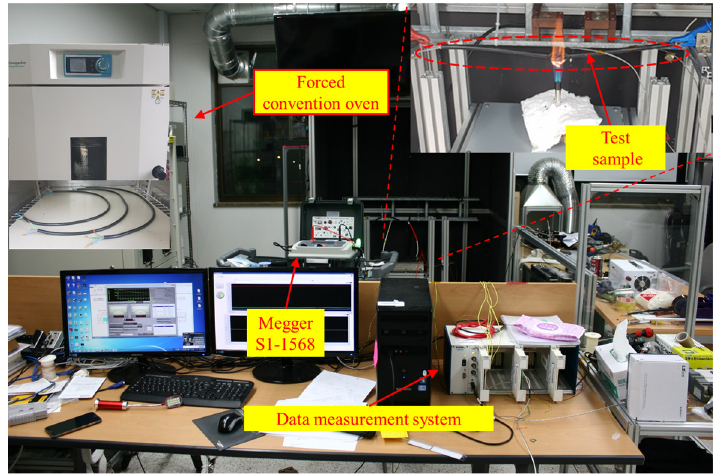
Figure 2. Experimental setup.